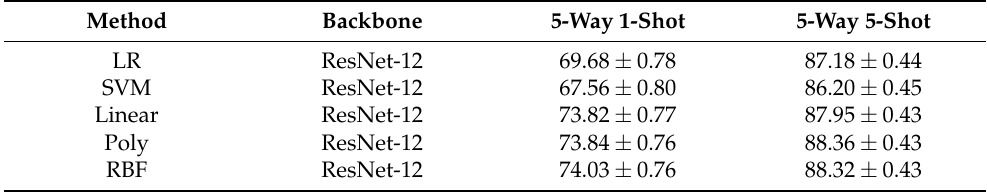
Table 6. Comparison results of the different methods in the NWPU-RESISC dataset.